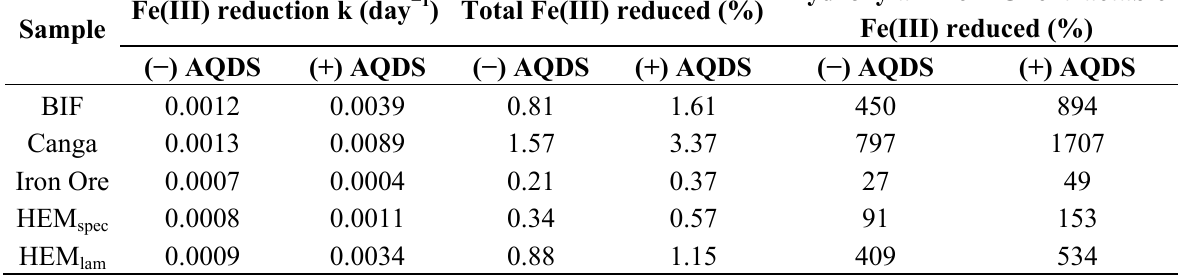
Table 2. Rates and extents of Fe(III) bioreduction in incubations containing S. oneidensis MR-1 and Fe(III)-containing